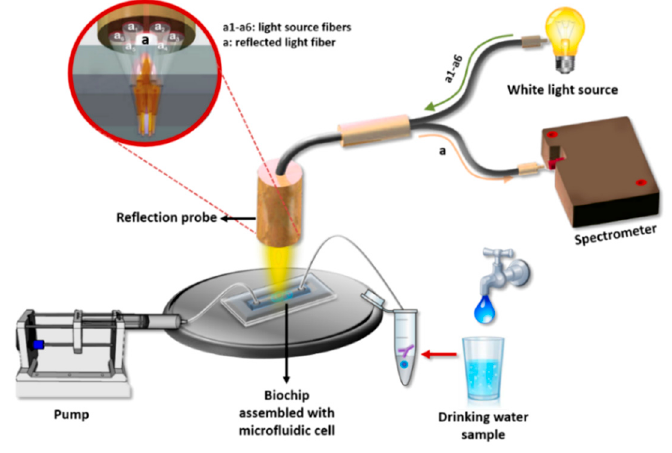
Figure 1. Illustration of the white light reflectance spectroscopy (WLRS) optical setup and sensing principle.